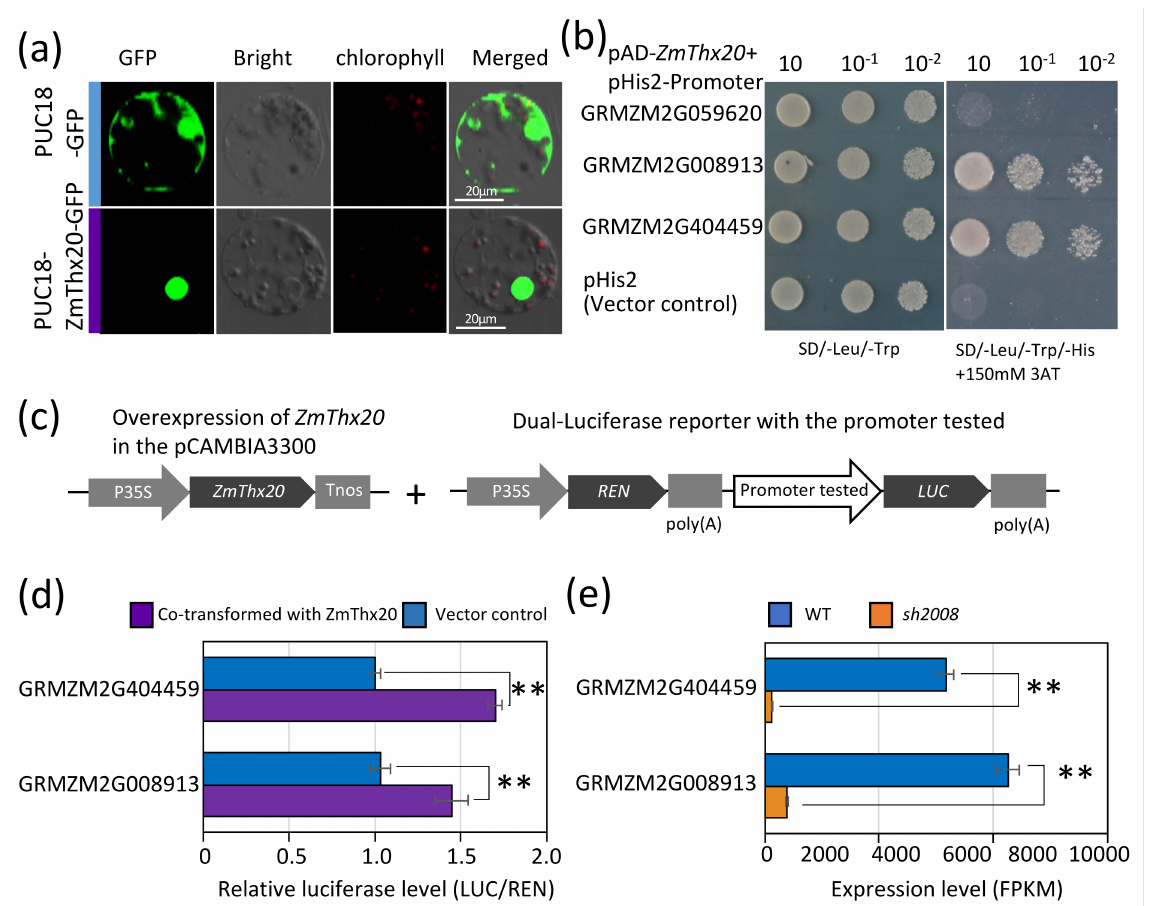
Figure 7. Sub-cellular localization and binding activity analysis of ZmThx20 . ( a ) Cell localization analysis of the ZmThx20. PUC18-P35S:: ZmThx20 -GFP was used for the cell localization analysis in the transient expression system. ( b ) The growth situation of yeast YM4271 transformed with pGADT7-ZmThx20 and pHis2-19kd zein promoter on SD/-Leu/-Trp and SD/-Leu/-Trp/-His+150 mM 3AT medium. The pHis2 plasmid was used as the negative control. ( c ) Diagram of the constructs of the effector and reporter in dual-LUC reporter gene. The 35S promoter (P35S), REN luciferase (REN), firefly luciferase (LUC), and terminator (Tnos) are indicated. ( d ) Transient transcription by dual-LUC assay. The full-length ORF of ZmThx20 was fused into the overexpression vector to produce P35S:: ZmThx20 -Tnos-P35S:: bar -Tnos. For the reporters, the promoters of 19 kDa zein were cloned into pGreenII0800-LUC. ( e ) Expression level of the selected 19 kDa zein genes in panels ( b , d ). ** indicates significance ( p < 0.01) using the Student’s t